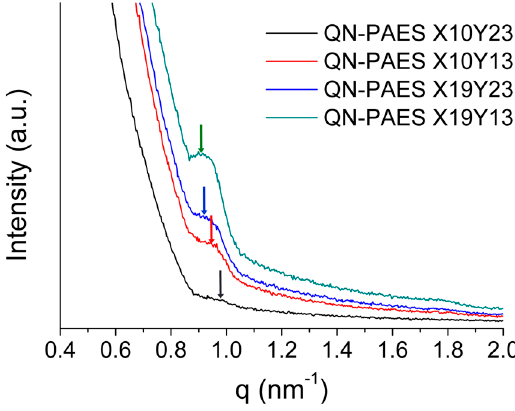
Figure 8. The SAXS patterns of QN-PAES membranes. Table 5. Scattering vector and Bragg spacing of the QN-PAES membranes calculated from SAXS data.